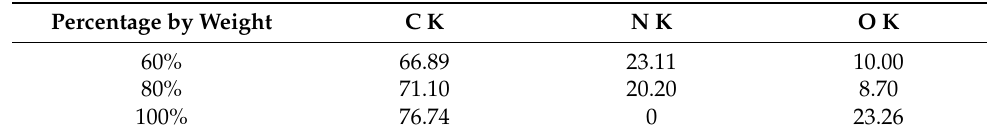
Table 2. EDS results of the 7:5 nanoscale urushiol/PAN film immersed in different concentrations of sulfuric